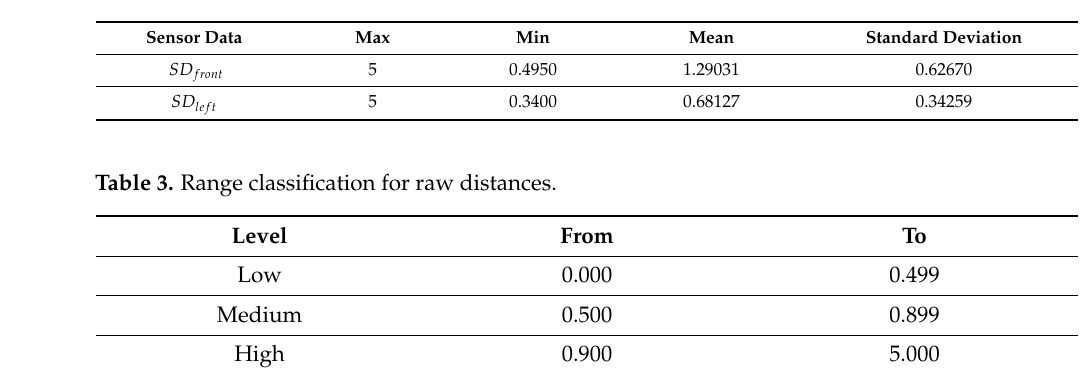
Table 2. Ultrasonic Sensors data statistics for raw distances.